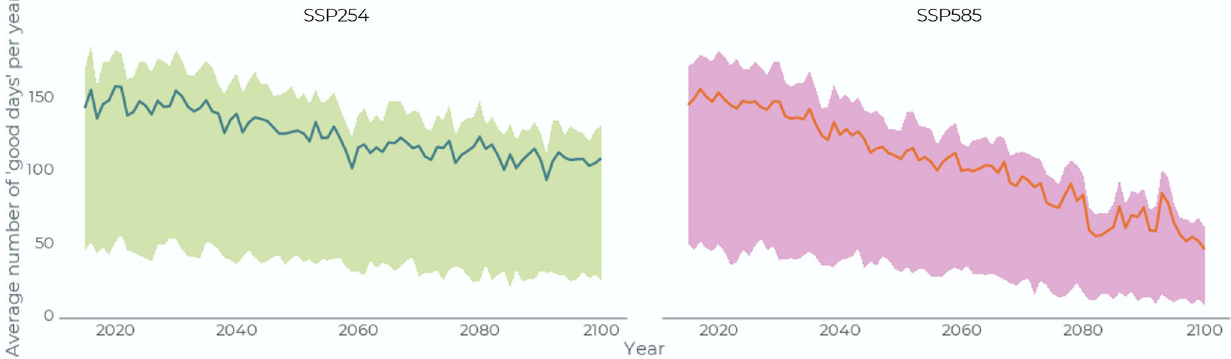
Fig. 5 Annual number of good sea ice trail days. Modeled for Type 1, 2, and 3 users, averaged across all communities for 2015 – 2100 for SSP245 and 585 (Type 1 users is the central line, type 2 is the lower line, type 3 the higher